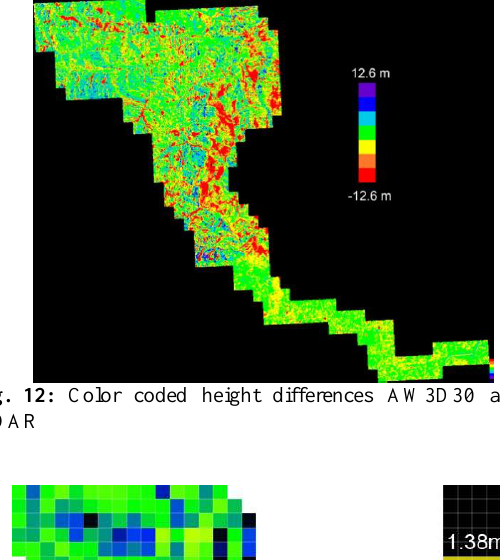
Fig. 9: Color coded height differences WorldDEM against LiDAR